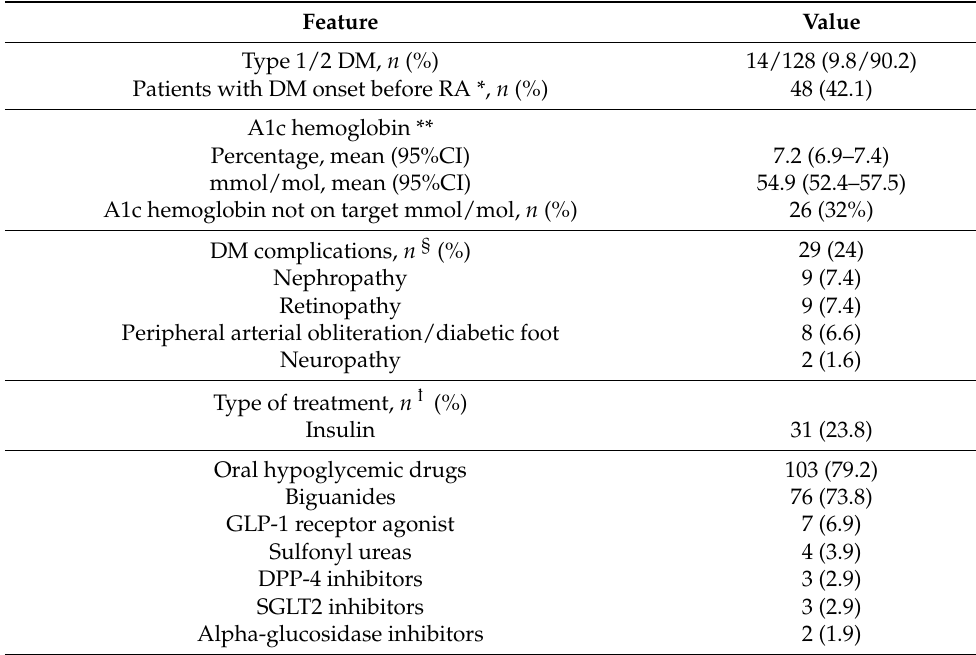
Table 3. Clinical features of 142 RA patients with DM.